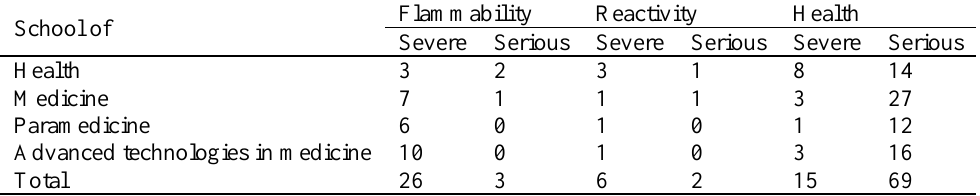
Table 3. Frequency of chemicals used in schools of Golestan University of Medical Sciences based on NFPA